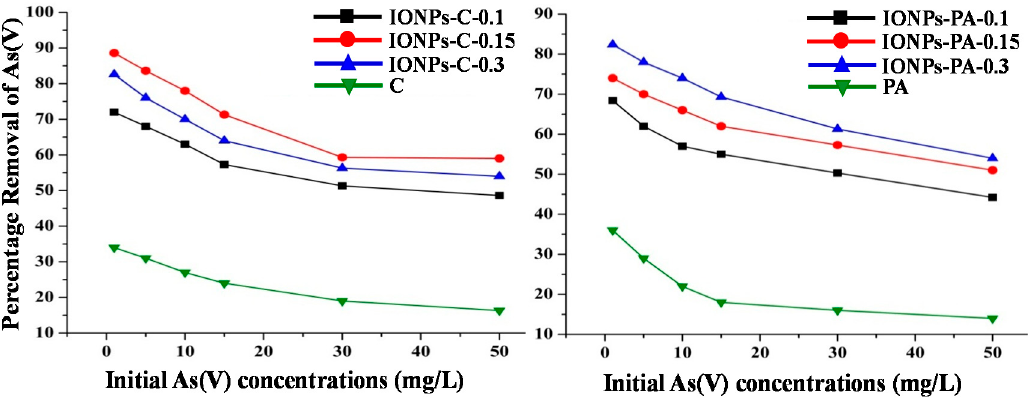
Figure 7. Effect of IONPs loading to chitosan nanocomposites (IONPs–C) and PVA–alginate nanocomposites (IONPs–PA) on removal of As(V).